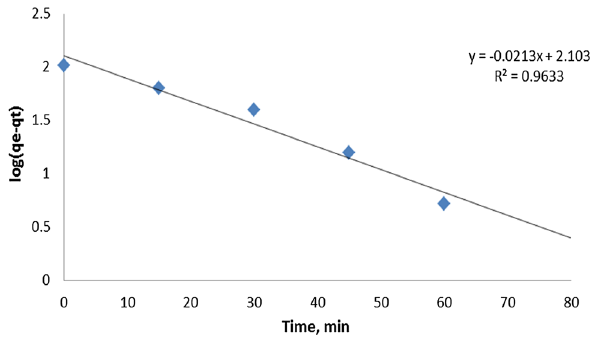
Fig. 8 Pseudo-first-order kinetic plot for biosorption of Cd(II) at 298 K and pH 5